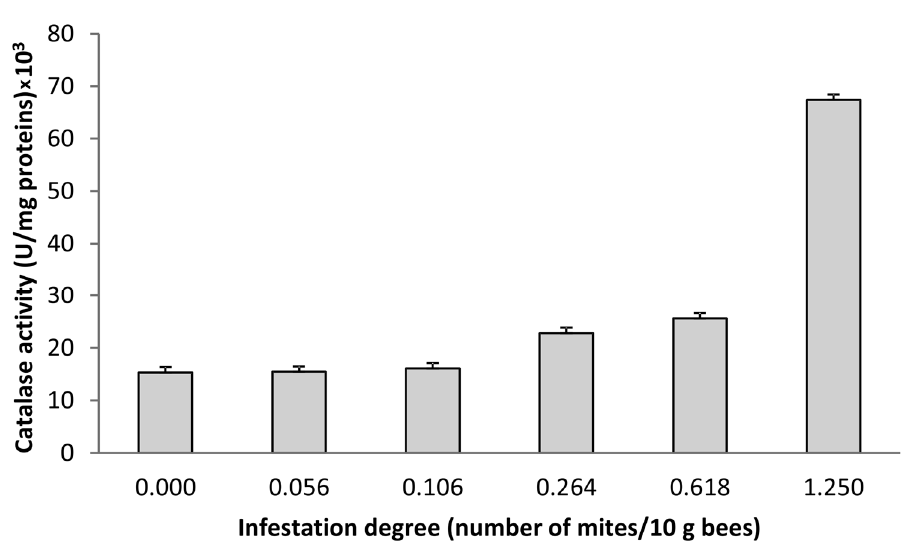
Figure 5. Dependence of catalase activity on the infestation degree with V. destructor .